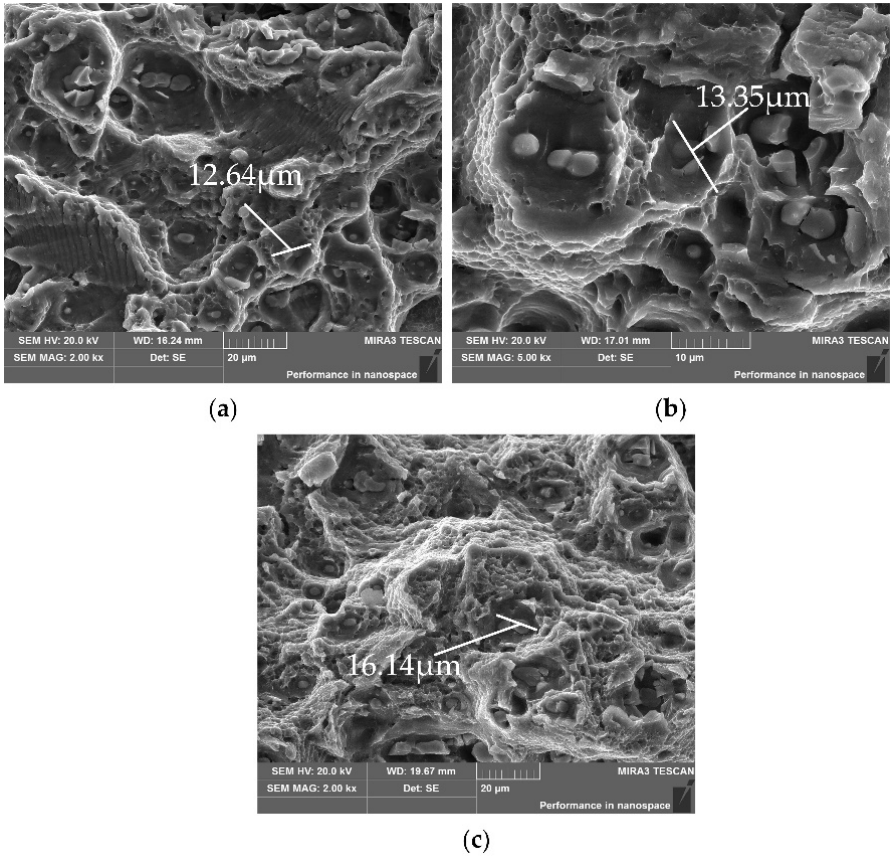
Figure 9. SEM images of the instantaneous break area under different curvature radii ρ : ( a ) ρ = 1000 mm; ( b ) ρ = 1500 mm; ( c ) ρ = 1800 mm.